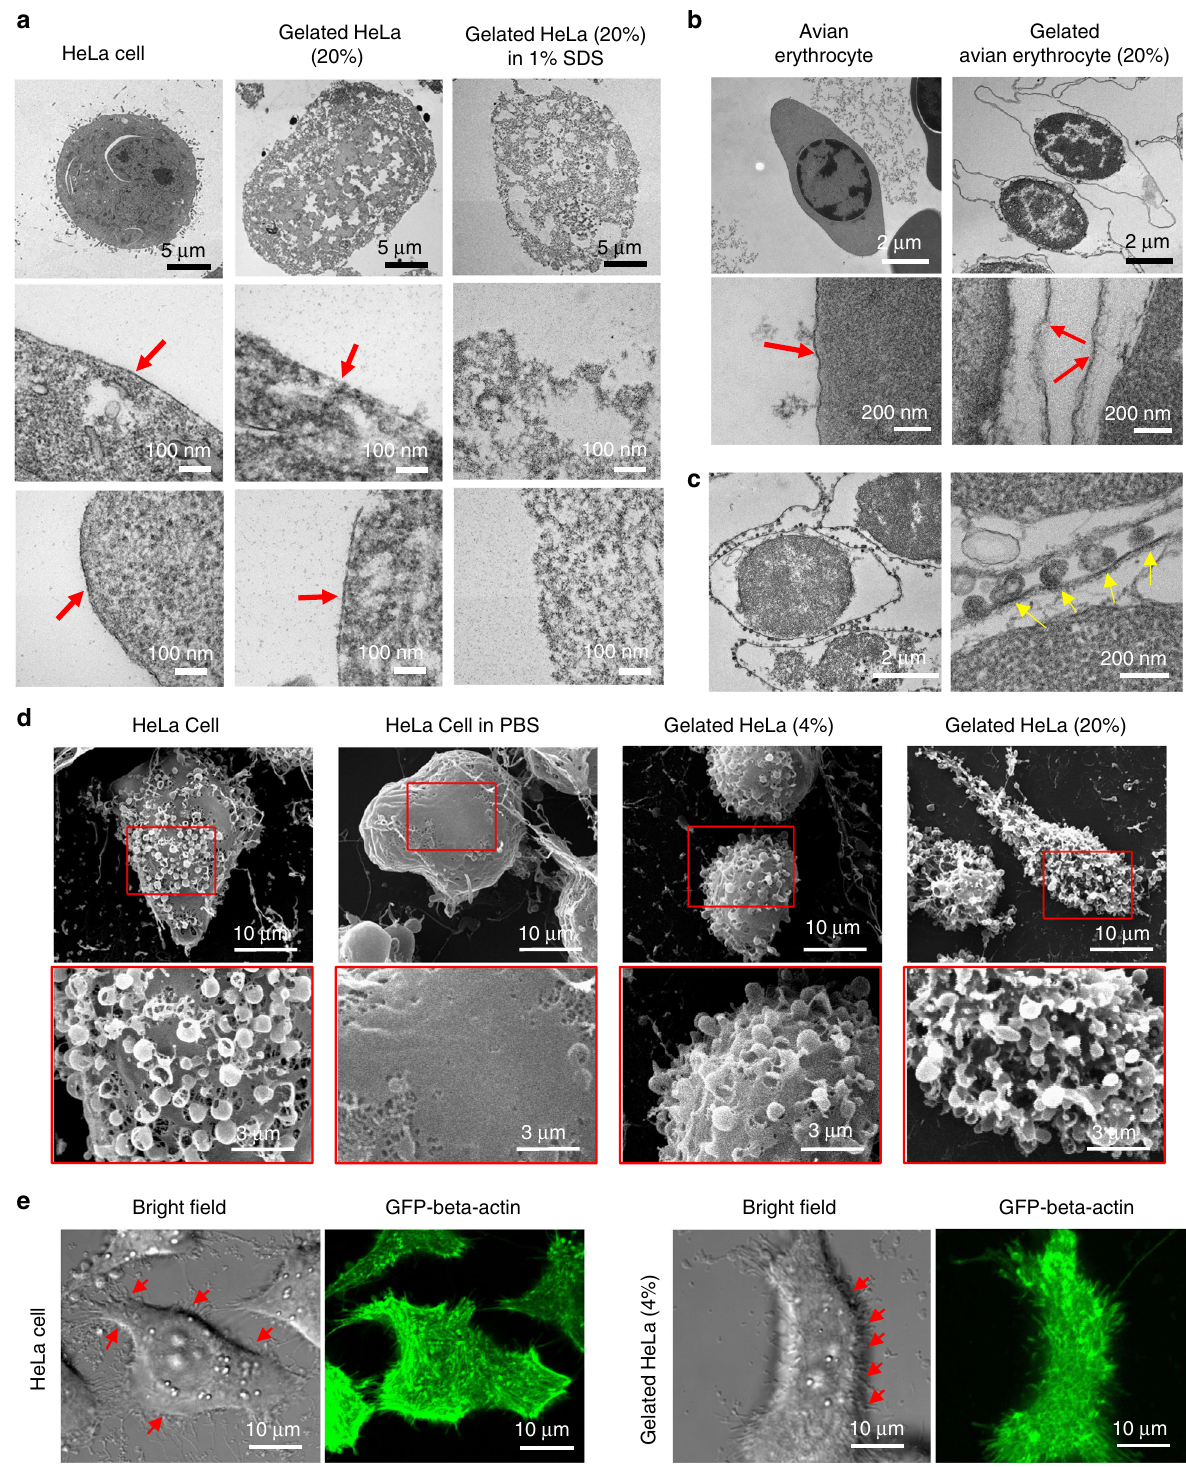
Fig. 2 Structural examination of GCs. a Transmission electron microscopy (TEM) images show the cross-sectional structure of normal HeLa cells (left), 20 wt% gelated HeLa cells (middle), and the hydrogel matrix of 20 wt% gelated HeLa cells following solubilization by 1% SDS (right). (scale bars = 5 μ m or 100 nm). Red arrows indicate cell membranes. b TEM cryosection images show the structure of avian erythrocytes and gelated avian erythrocytes (20 wt% PEG-DA) and c binding of hemagglutinating in fl uenza viruses on the surfaces of gelated avian erythrocytes (scale bars = 2 μ m or 200 nm). Red arrows indicate cell membranes. Yellow arrows indicate in fl uenza viruses. d Cryogenic scanning electron microscopy (Cryo-SEM) images show the surface features of live HeLa cells, HeLa cells in PBS for 4 h, 4 wt% gelated HeLa cells in PBS, and 20 wt% gelated HeLa cells in PBS. Membrane ruf fl es were observed on the gelated cells. Scale bars = 10 μ m (top row) and 3 μ m (bottom row). e HeLa cells transfected with plasmids carrying actin-GFP and the corresponding 4 wt% GCs were imaged under bright- fi eld and fl uorescence microscopy. Preservation of actin fi lament was observed in the GCs. Red arrows indicate membrane ruf fl es, scale bars = 10 μ